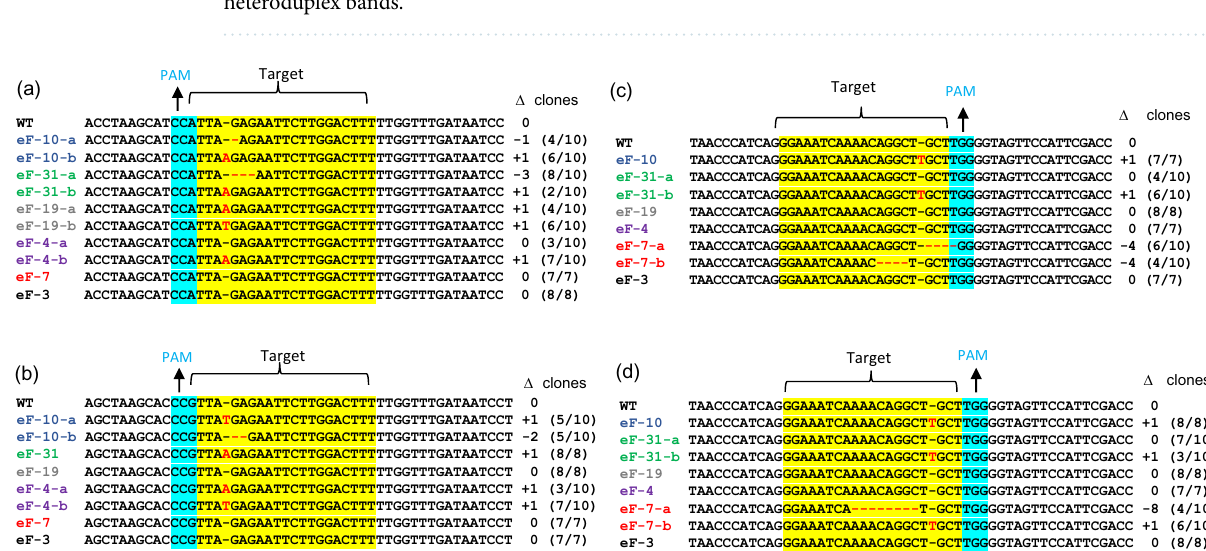
Figure 2. Identification of CRISPR/Cas9-induced mutations in the eIF4E genes by heteroduplex analysis. ( a – d ) PAGE-based heteroduplex analysis of eIF4E1-S , eIF4E1-T , eIF4E2-S and eIF4E2-T , respectively. eF-3– eF-31: T0 tobacco mutant lines. WT wild type plant, M marker 100 bp, Thermo Scientific. Red triangles denote heteroduplex bands.